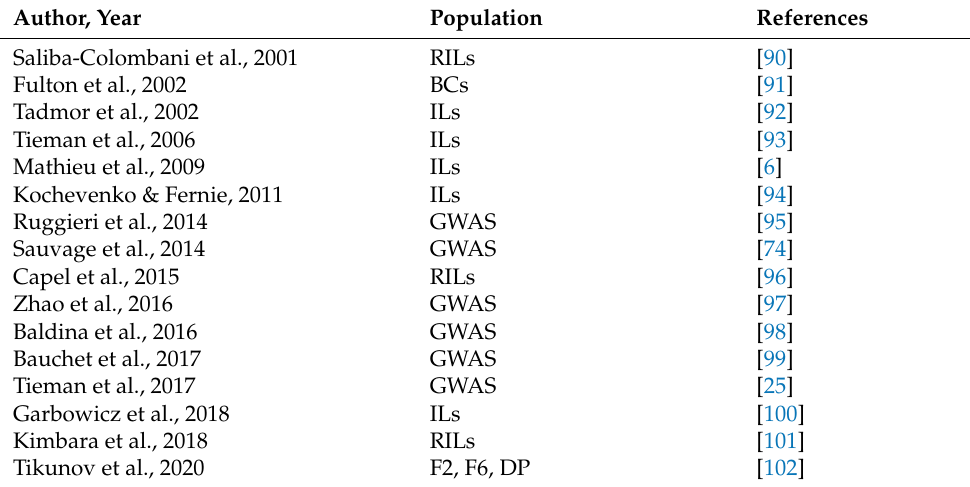
Table 2. List of the articles reporting QTLs for tomato aroma included in the review. RILs: Recom- binant Inbred Lines; BCs: Backcross population; ILs: Introgression Lines; GWAS: Genome-Wide Association Studies; DP: Diversity